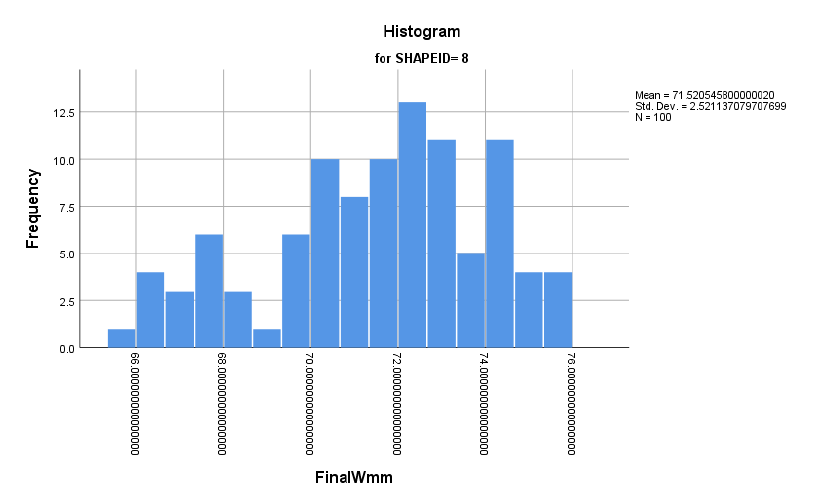
Figure A18. Grow width adjustment for 70 mm.